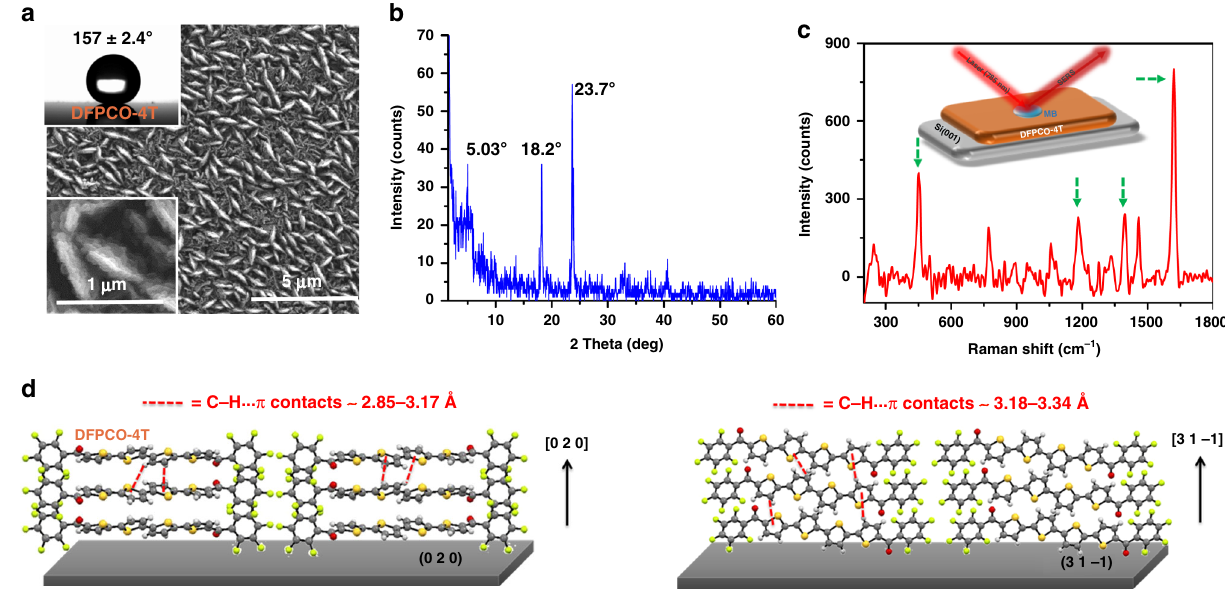
Fig. 3 Characterization and SERS response of DFPCO - 4T fi lms. a SEM images of nanostructured DFPCO - 4T fi lms and, inset, optical image of a water droplet on DFPCO - 4T fi lm. b The θ – 2 θ XRD pattern of DFPCO - 4T fi lm. c SERS spectrum of MB (10 − 3 M) on DFPCO - 4T (the characteristic peak positions are highlighted). d Schematic illustration of the molecular packing diagram in the out of plane direction ([0 2 0] and [3 1 − 1]) simulated from the single- crystal structure parameters showing representative C – H··· π interactions (red dashed